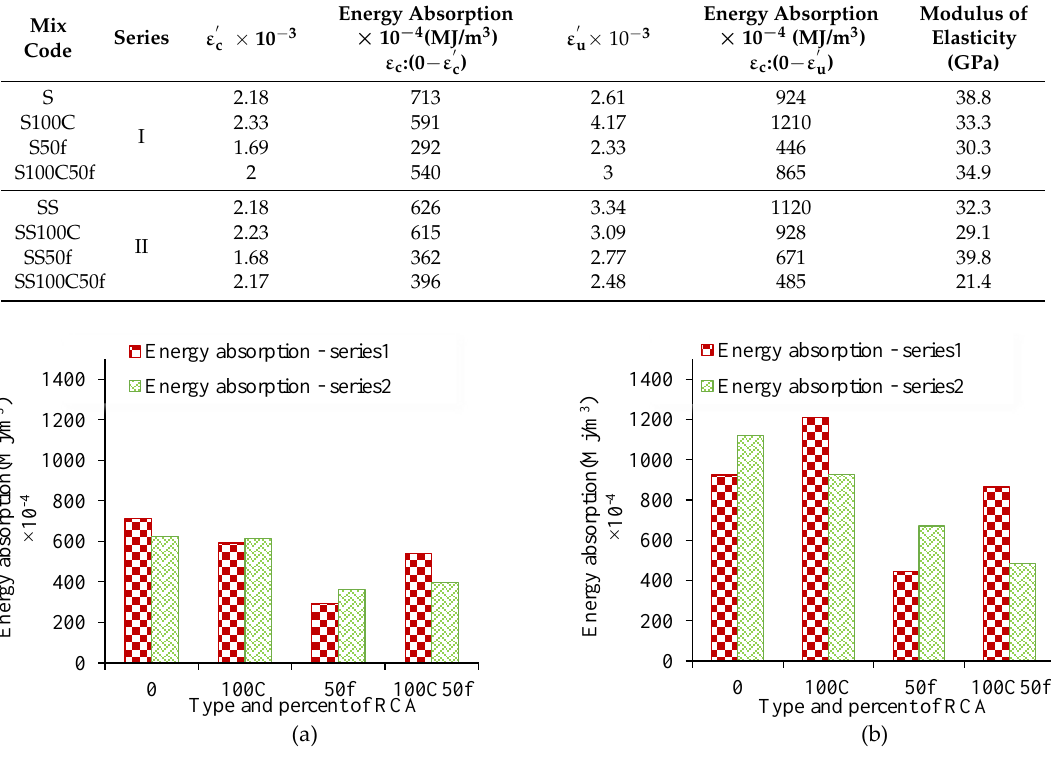
) , and ( b ) ε c : ( 0 − ε (cid:48) c